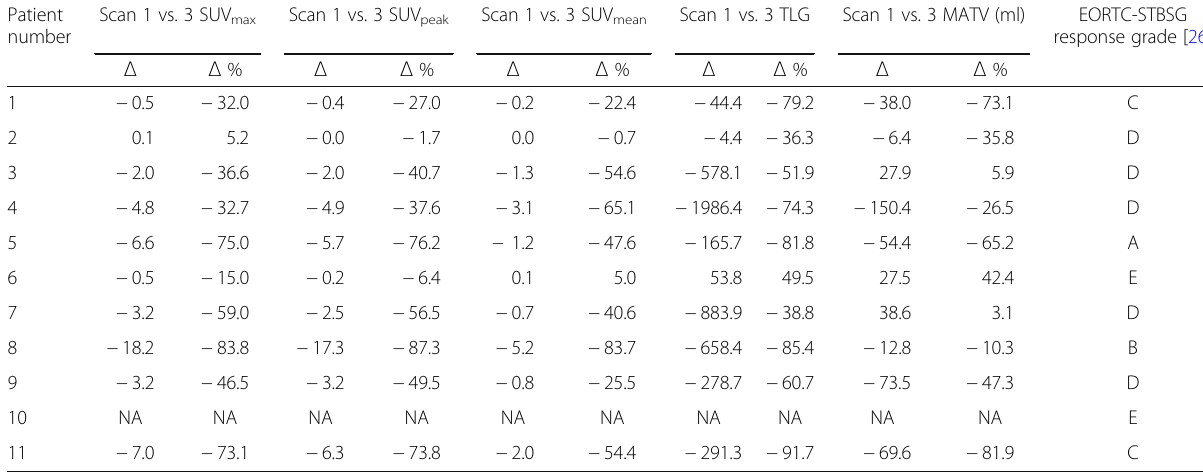
Table 5 Changes in metabolic tumor activity for the VOI man during the neoadjuvant treatment between 18 F-FDG PET-CT scans 1 and 3, combined with the corresponding histopathologic tumor response for each patient Patient Scan 1 vs. 3 SUV number